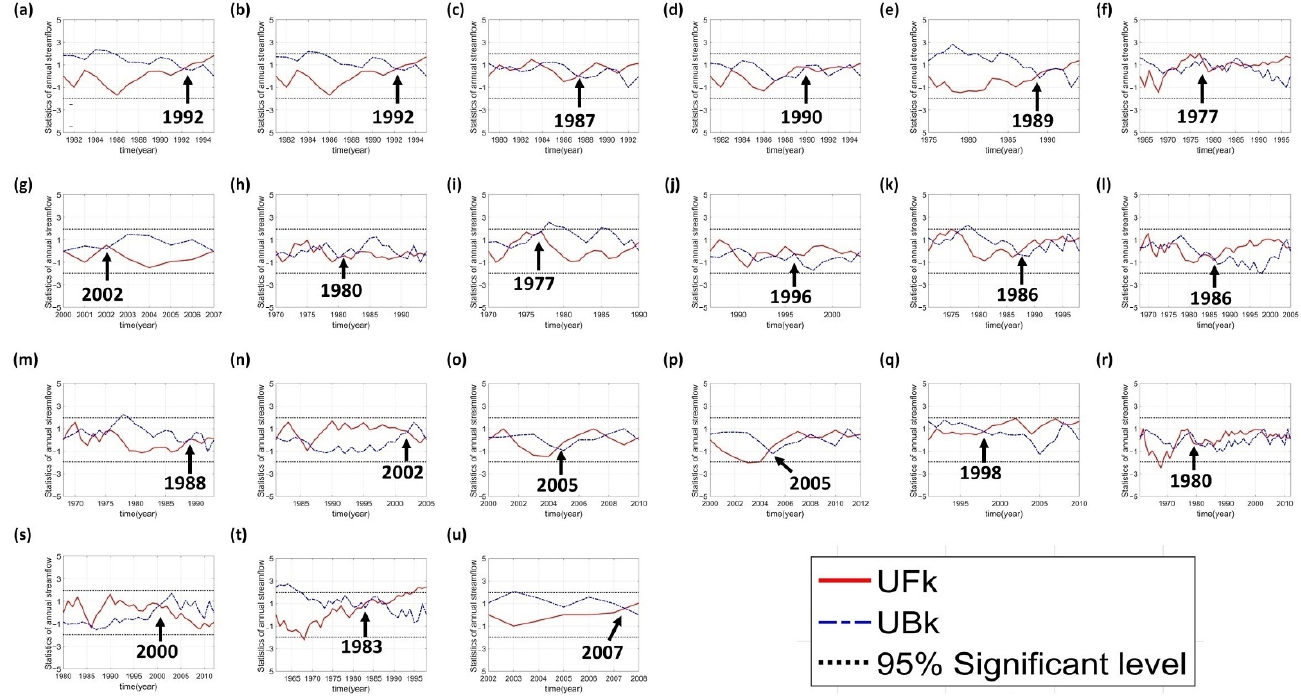
Figure 9. Mann–Kendall test for annual streamflow in each sub ‐ basin and year of abrupt change from ( a ) QZ, ( b ) LX, ( c ) ZG, ( d ) JH, ( e ) ZZ, ( f ) XF, ( g ) SZ, ( h ) QSD, ( i ) NXK, ( j ) LQ, ( k ) WZ, ( l ) JJK, ( m ) SB, ( n ) BY, ( o ) SZ, ( p ) XK, ( q ) DT, ( r ) BZA, ( s ) SD, ( t ) QDC, and ( u ) CCL.